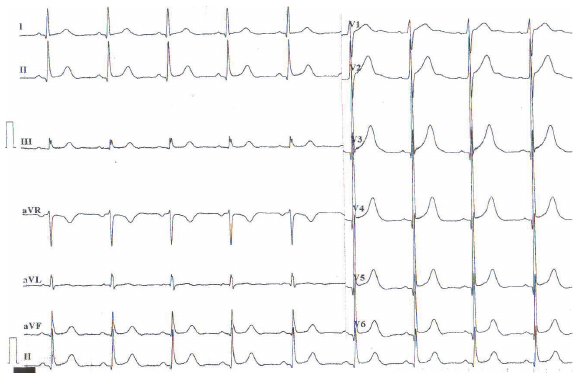
Figure 6: ECG at admission at 9:30 a.m. on August 4, 2013.